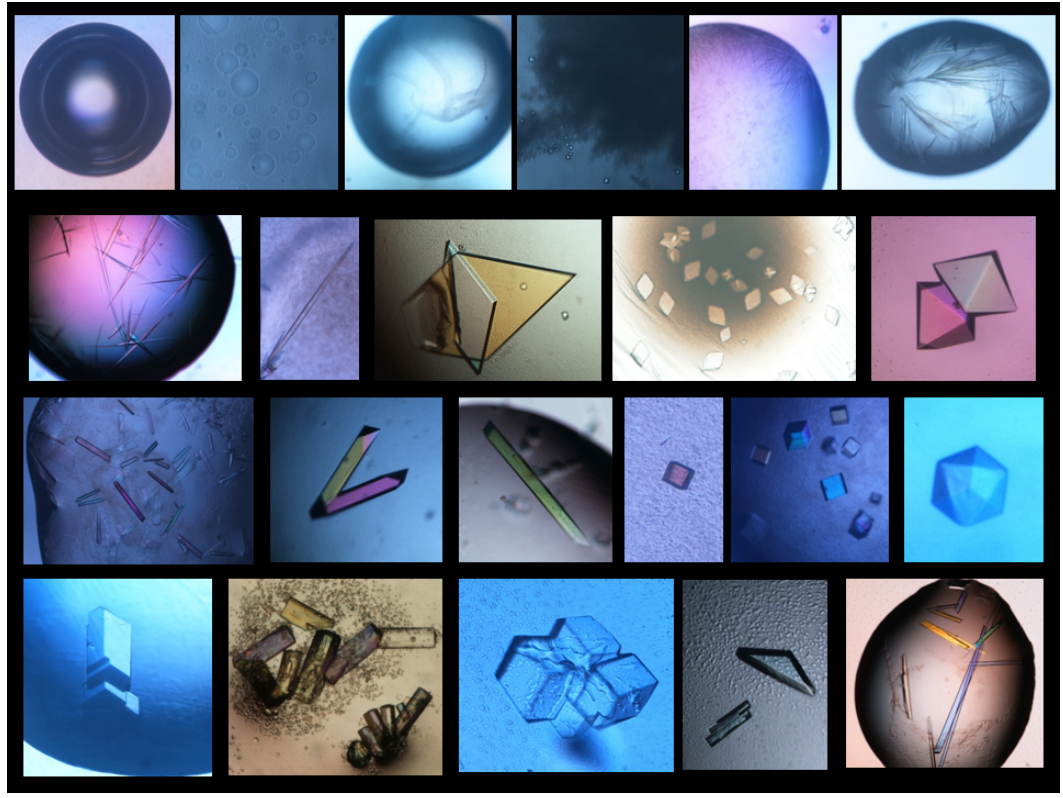
Figure 10. A few examples of crystallization droplets. On the first row, from left to right, limpid droplet, oil, light precipitate, heavy precipitate, quasi-crystals, brushes of needle crystals. On the last three rows well-formed crystals of different